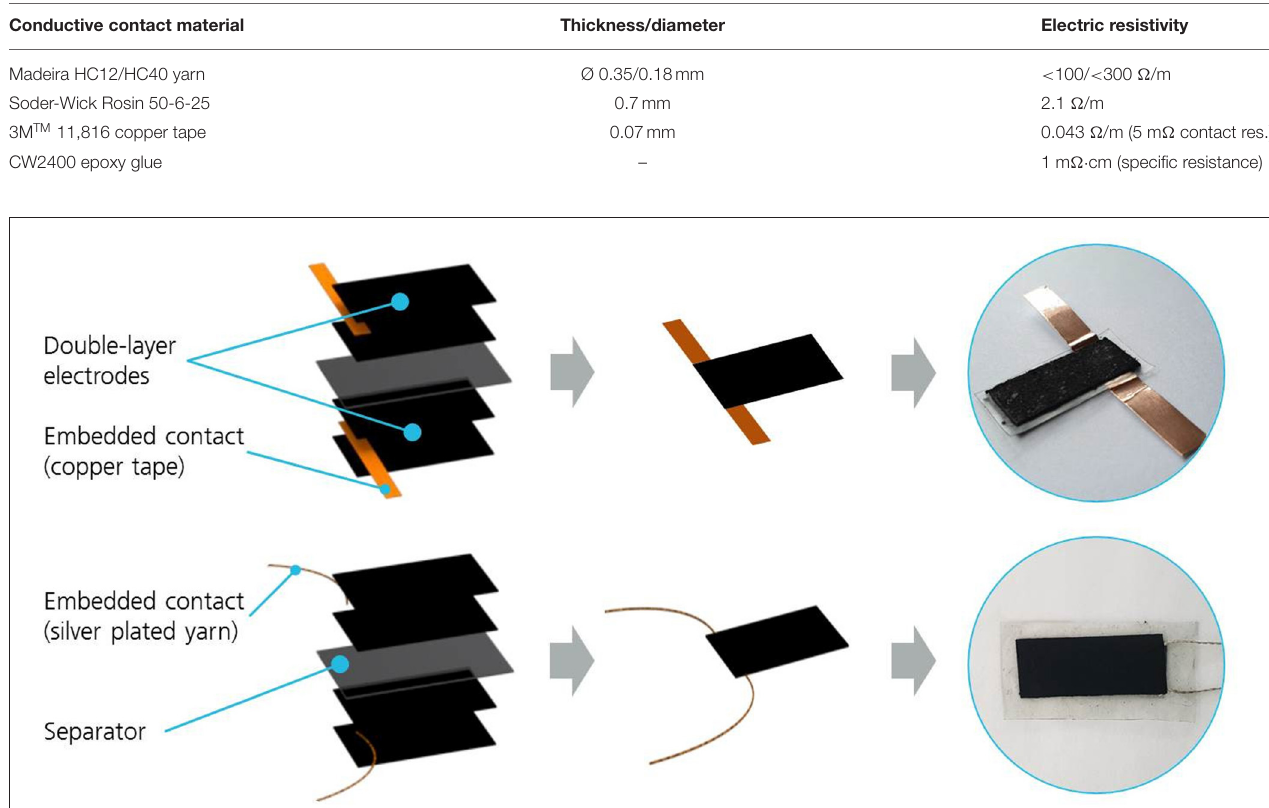
TABLE 1 | Dimension and resistivity values of commercial conductive materials used for embedding electric contacts into IEAP actuators and sensors.